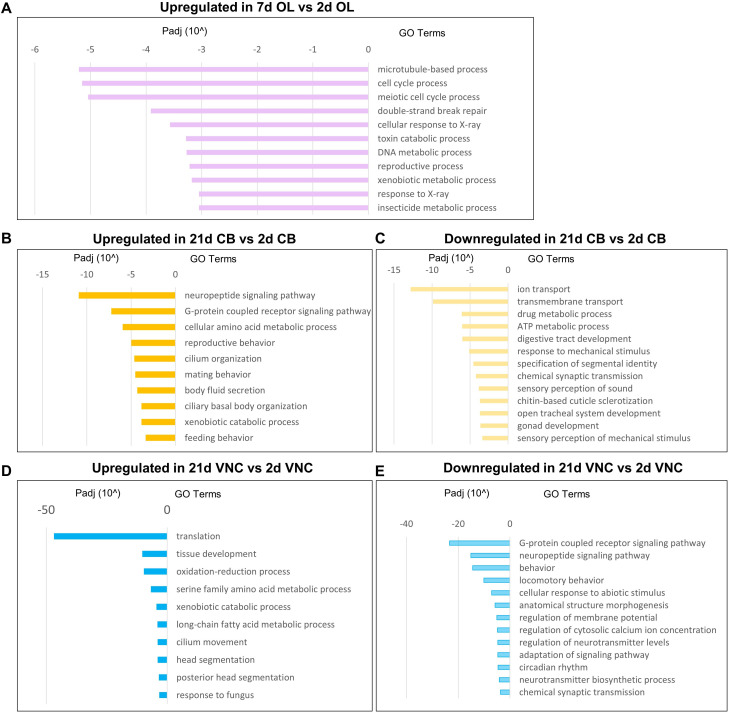
Supplemental RNAseq GO analysis.(A) Most significantly upregulated GO terms in 7d OL compared to 2d OL. Most significantly upregulated (B) and downregulated (C) GO terms in 21d CB compared to 2d CB. Most significantly upregulated (D) and downregulated (E) GO terms in 21d VNC compared to 2d VNC.